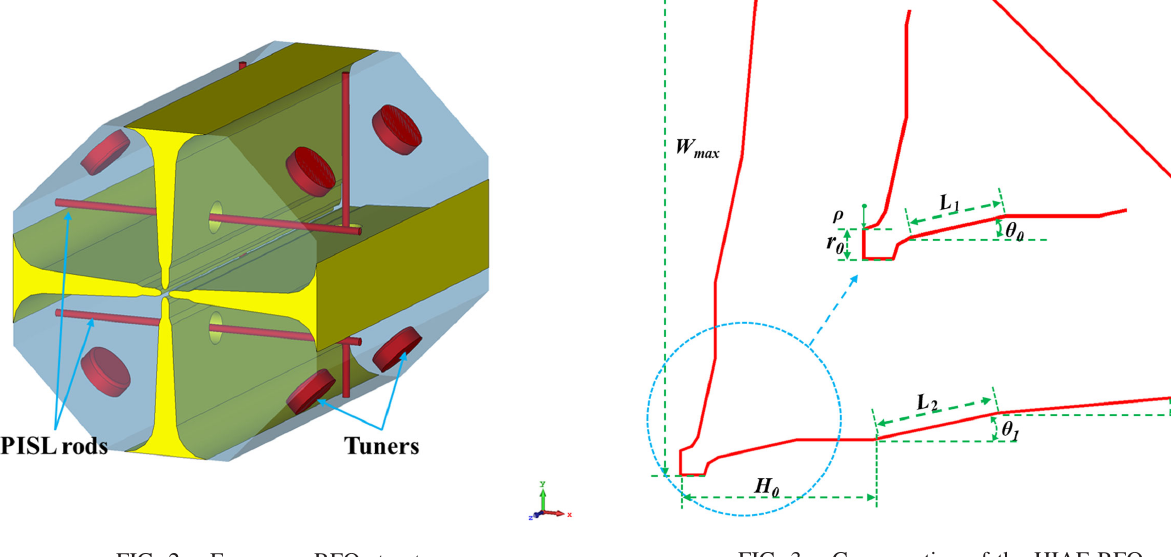
FIG. 2. Four-vane RFQ structure. FIG. 3. Cross section of the HIAF